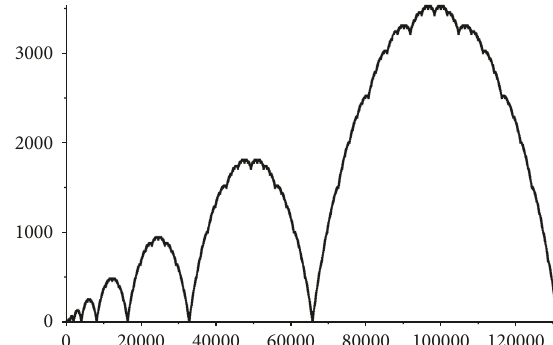
Figure 2: Hofstadter-Conway $10000 sequence, minus 𝑛/2 .